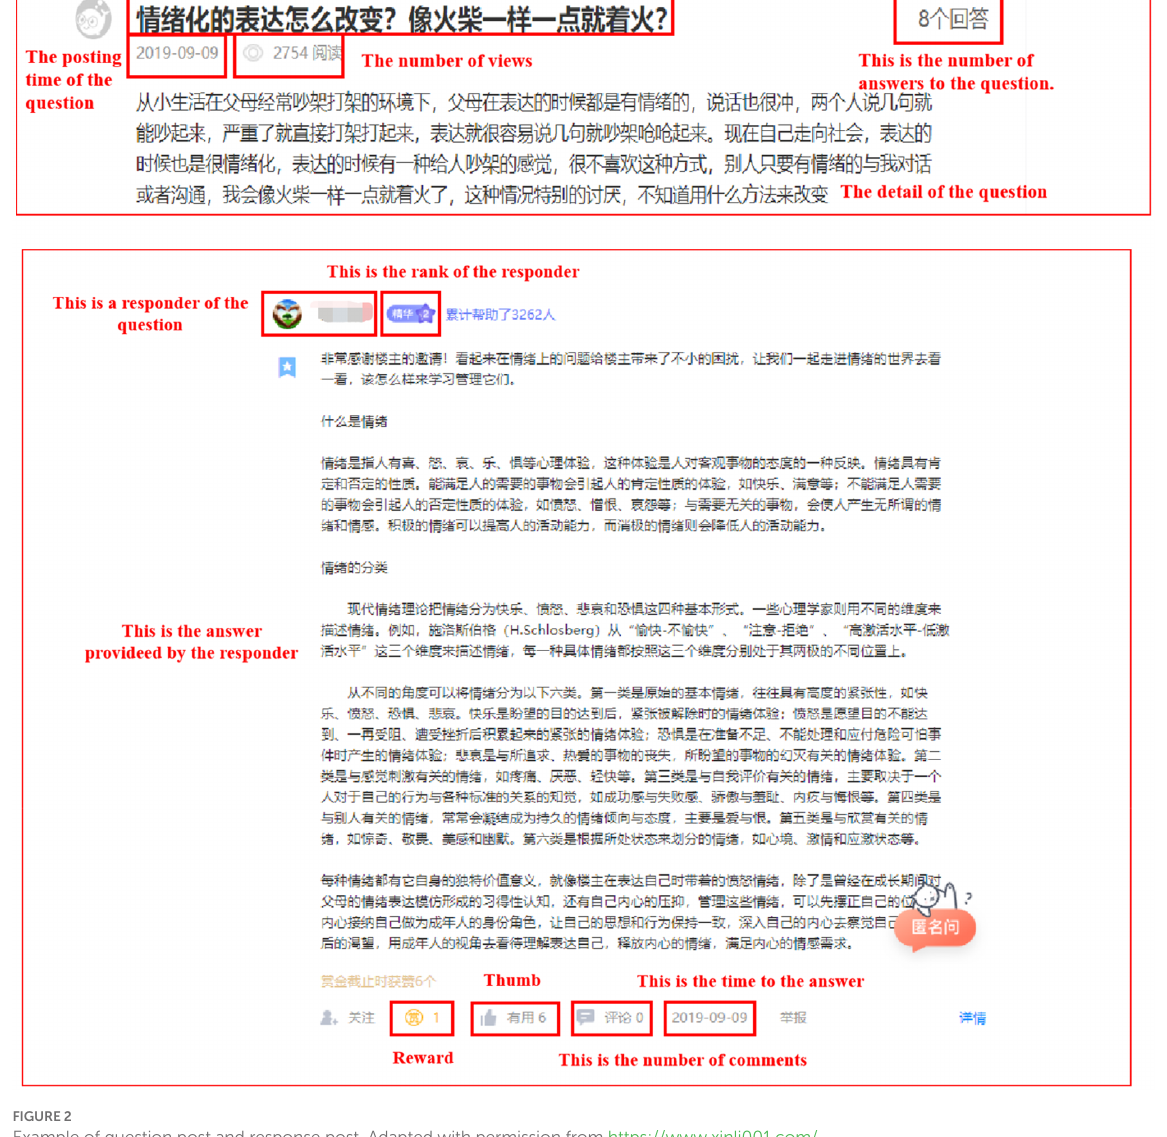
FIGURE 2 Example of question post and response post. Adapted with permission from